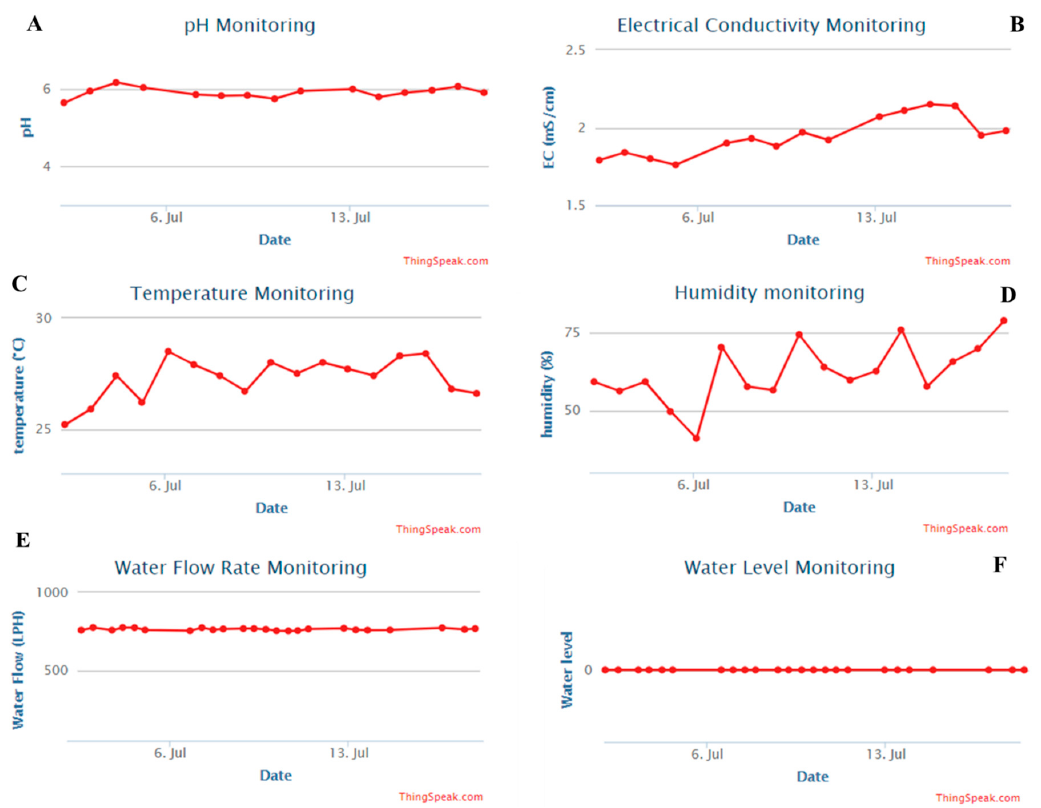
Figure 9. Sample graphs of the Thingspeak Web-interface of IoT platform: ( A ) pH, ( B ) EC, ( C ) Temperature, ( D ) Humidity, ( E ) Water flow rate, and ( F ) Water level monitoring.